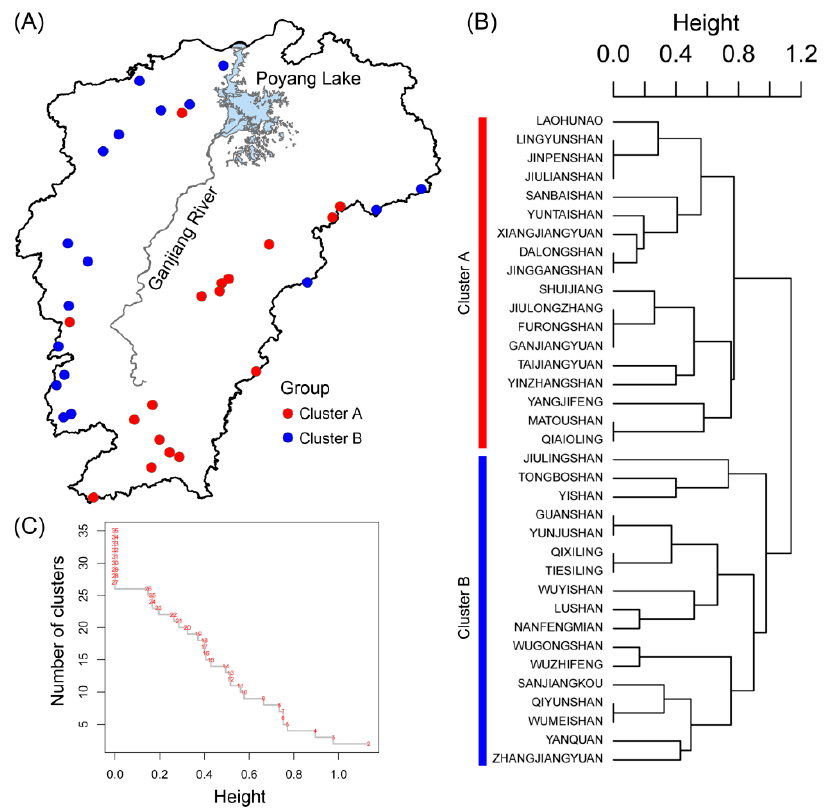
Figure 6. Map ( A ), dendrogram ( B ), and fusion level ( C ) resulting from ward hierarchical clustering